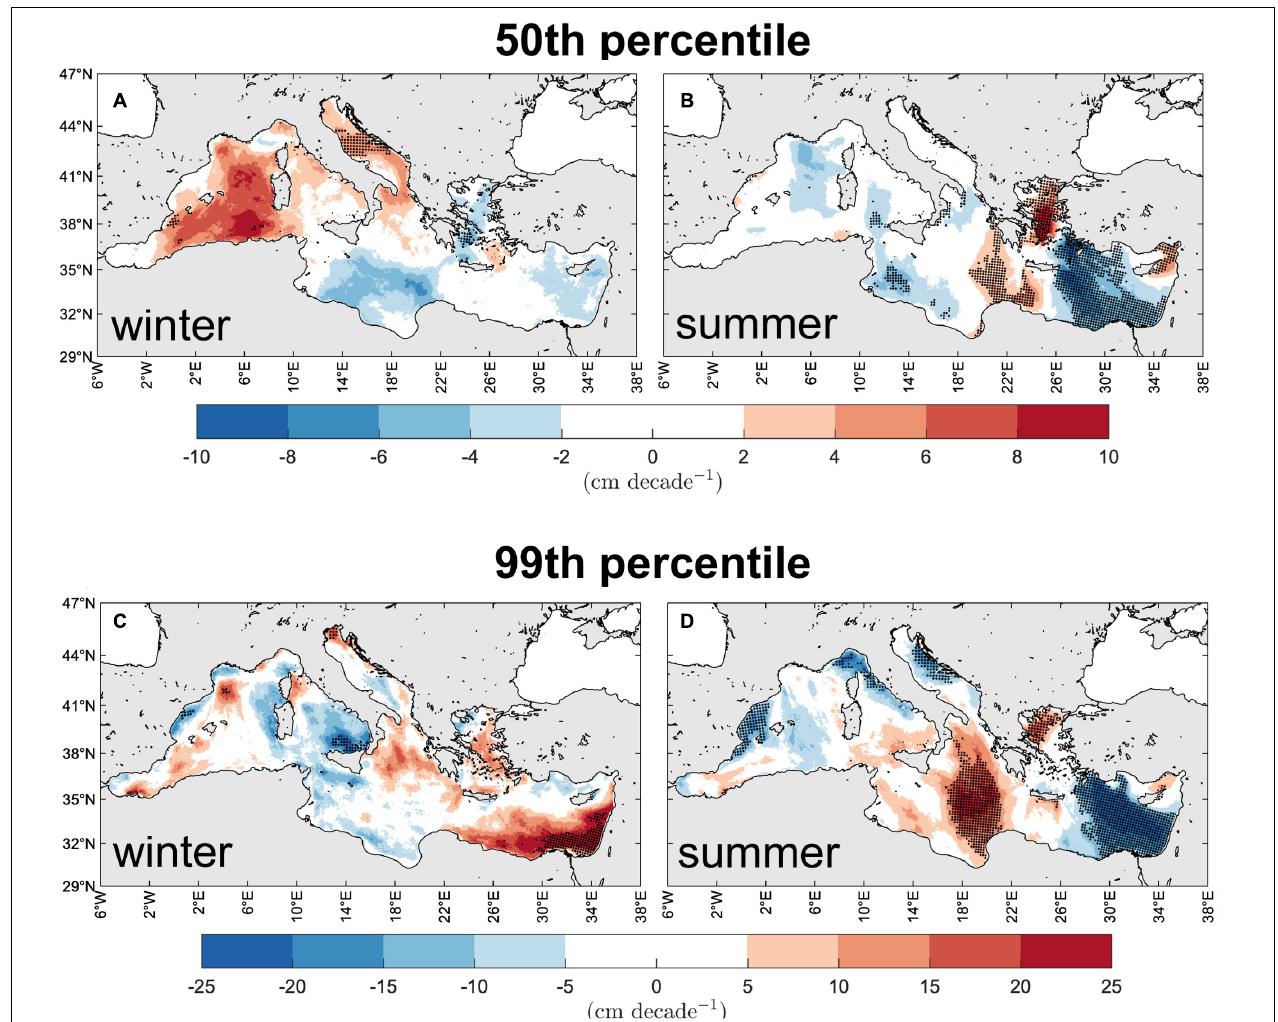
FIGURE 11 | Change of the MS typical [50th percentile, panels (A,B) ] and extreme [99th percentile, panels (C,D) ] maximum individual wave climate. Trend of the winter [panels (A,C) ] and summer [panels (B,D) ] H max during 1981–2019. Areas with statistically significant trends at the 90% confidence intervals are denoted by black dots (decimated for graphical